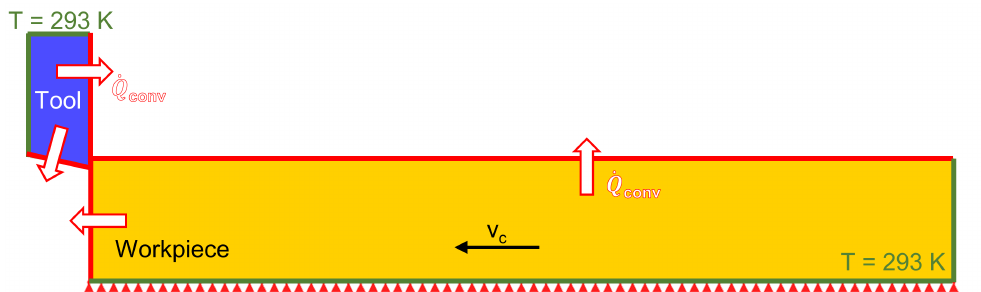
Figure 3. Thermomechanical boundary conditions for the FEM and SPH metal cutting